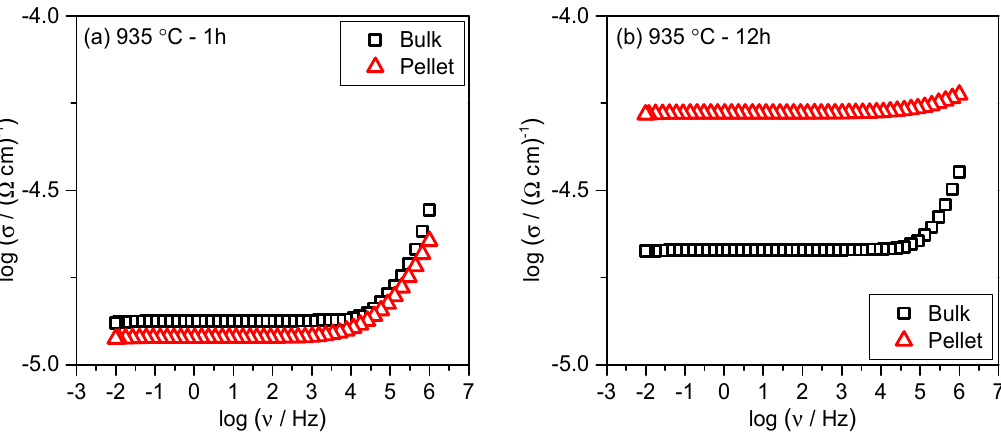
Figure 6. Comparison of the conductivity spectra measured at 30 ° C for glass-ceramics prepared from the bulk glass (black squares) and pelleted glass powder (red triangles) at 935 ° C for ( a ) 1 h and ( b ) 12 h.